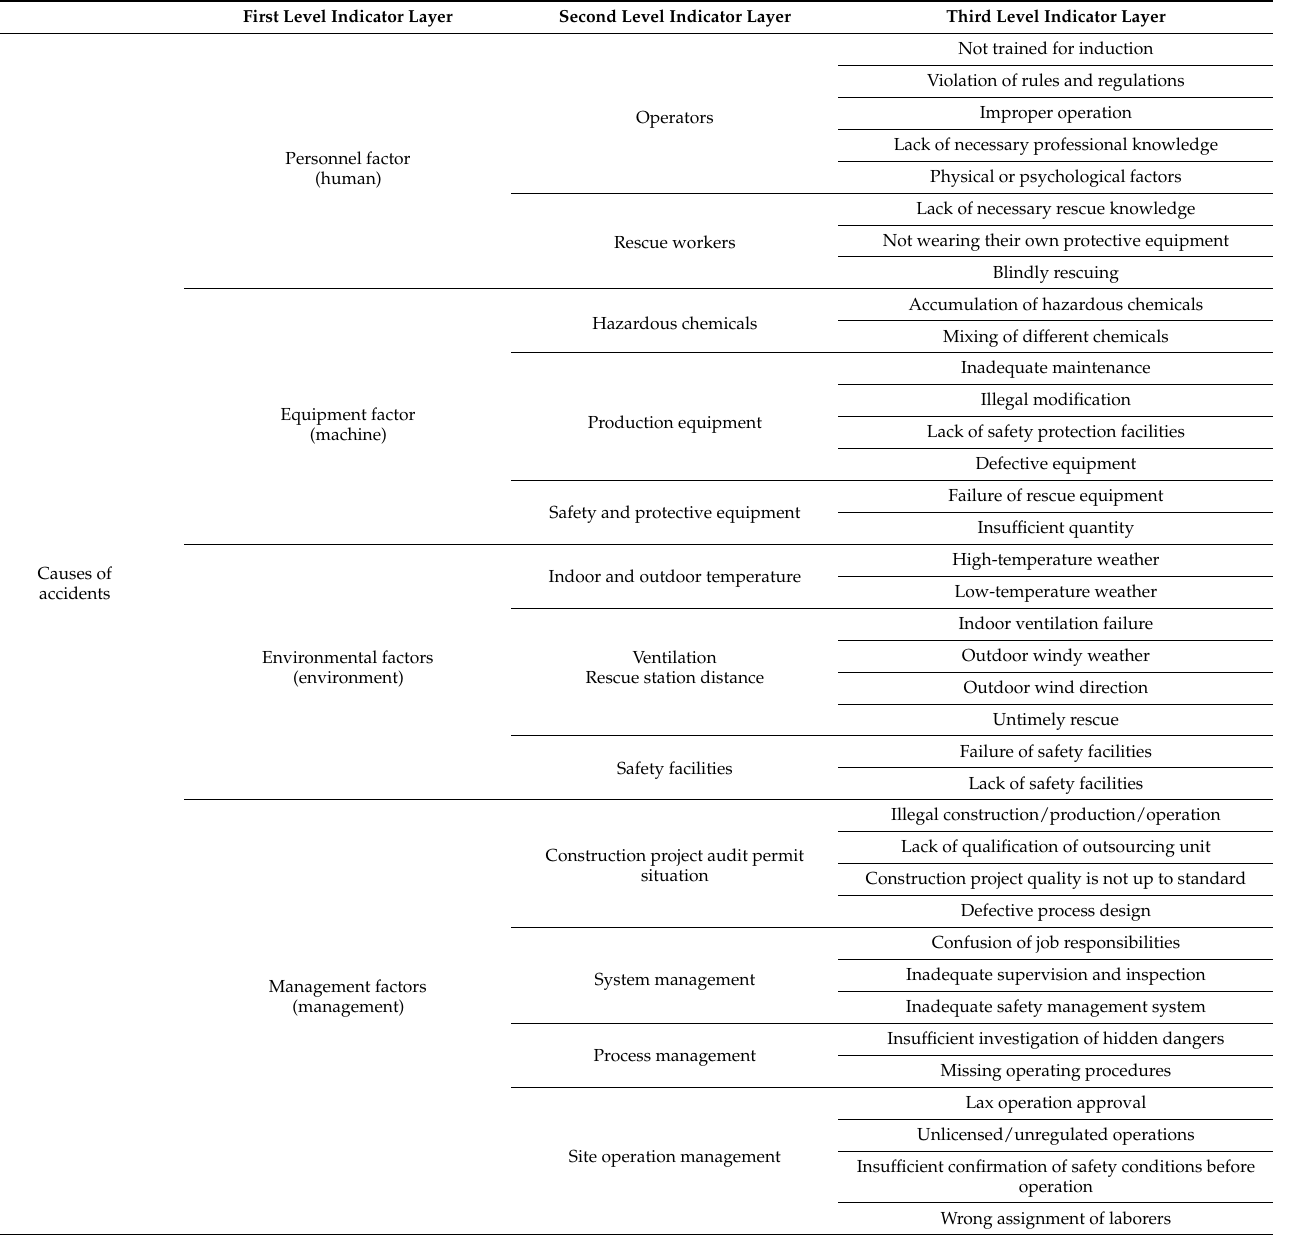
Table 2. List of accident risk